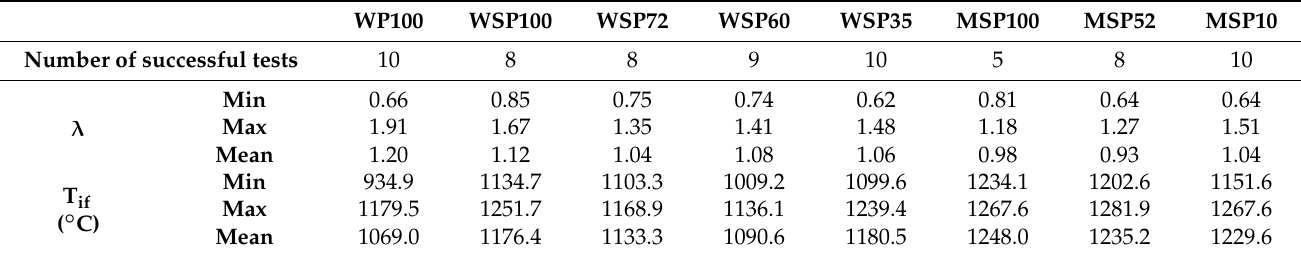
Table 8. Summary of reactor tests features.